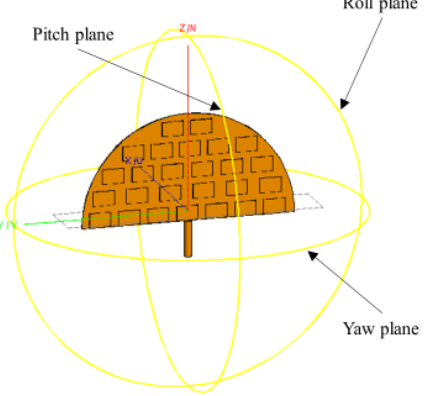
Figure 12. Schematic diagram of three incident orientations.